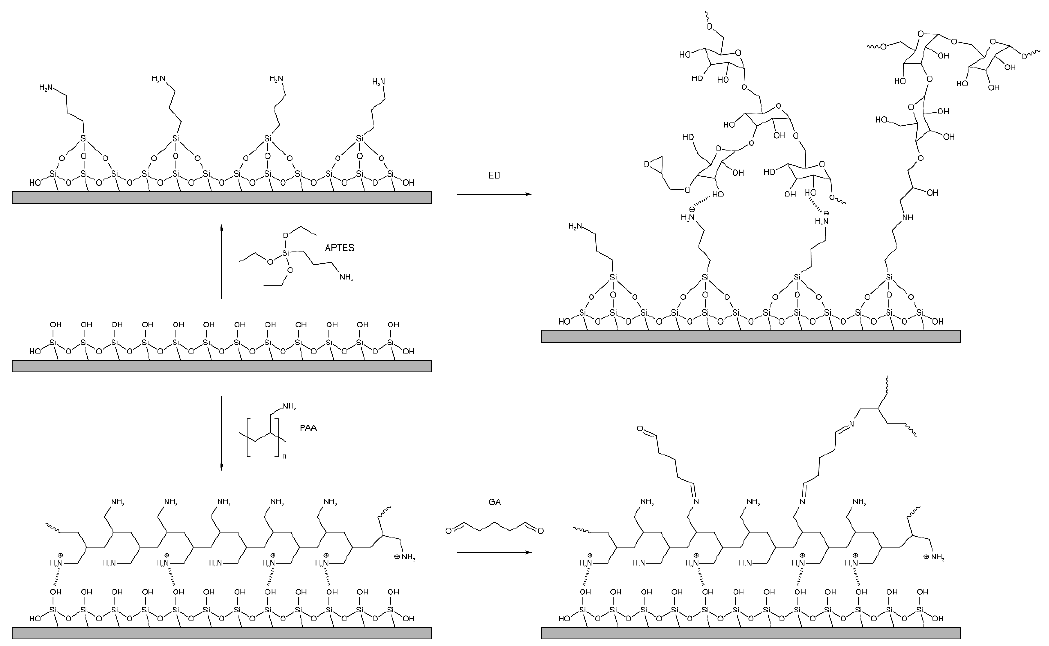
Figure 4. Modification of the chip surface: introduction of active amino groups on the chip surface (APTES treating) following ED modification for further dextran coupling and PAA and GA modi- fication.